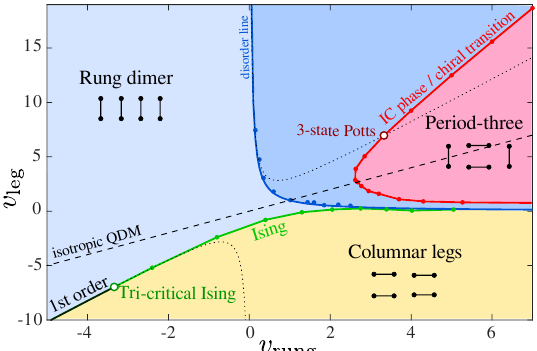
Figure 9: Phase diagram of the quantum dimer model Eq. 1 as a function of its natural coupling constants v and v . It is just a reformulation of that of Fig.8 leg rung = V and v = U + 3 V . The dashed line stands for the isotropic QDM with v rung leg = v defined by v and studied in details in rung leg